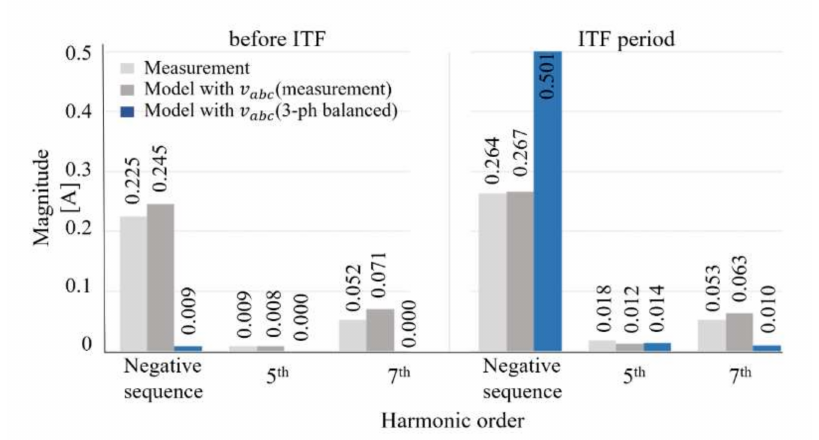
Figure 9. Magnitude of negative sequence, 5th and 7th harmonic current of D, Q-axis currents i s and i s qs of Figure